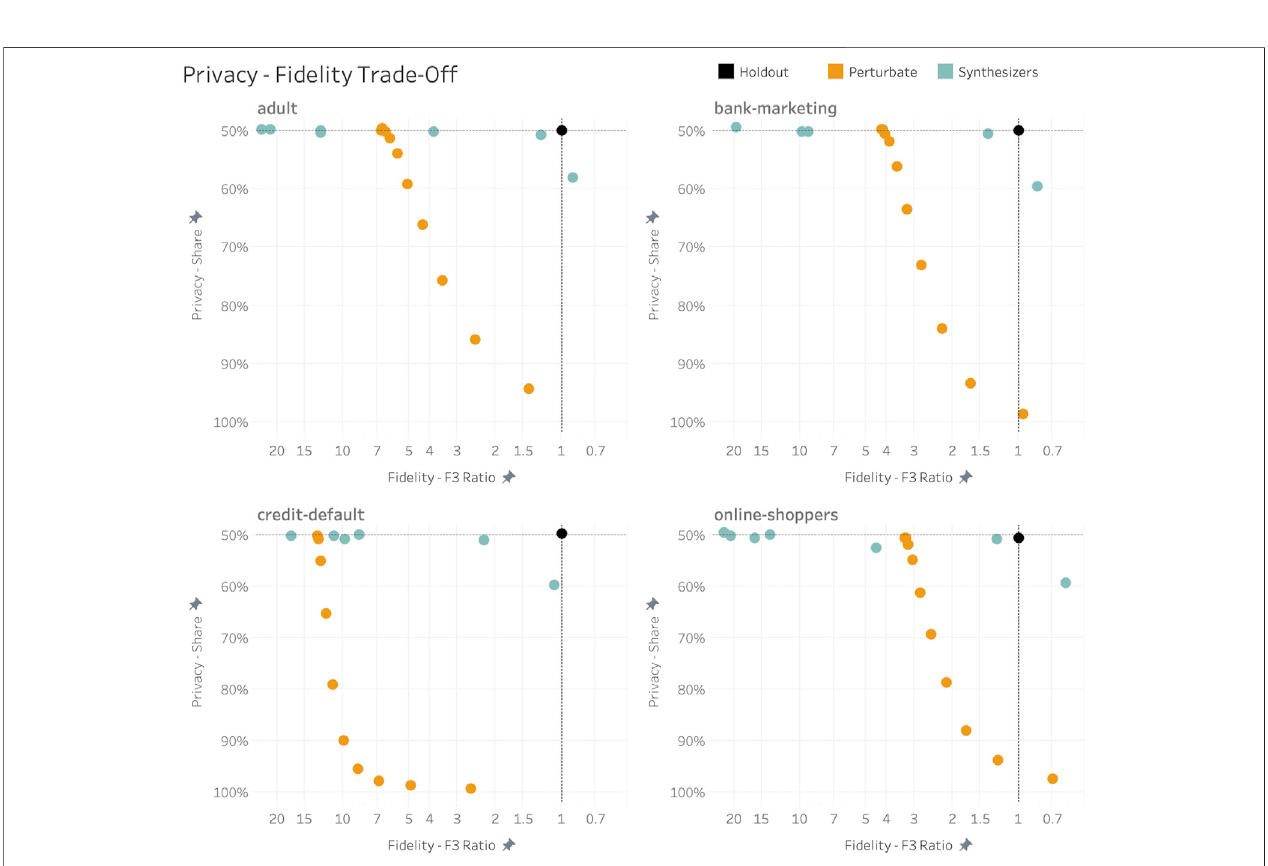
FIGURE 11 | Empirically established trade-off between privacy and fi delity across synthetization and perturbation approaches. Fidelity is displayed as the ratio F 3 (T,S)/F 3 (T,H),astheholdoutdatasetservesasmaximumattainablereferencepoint.Incontrasttosynthesizeddata,perturbationtechniquesfailtoprotectprivacywithoutsacri fi cing fi delity.